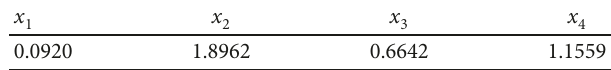
Table 2: Scores of four components of Hald cement. x